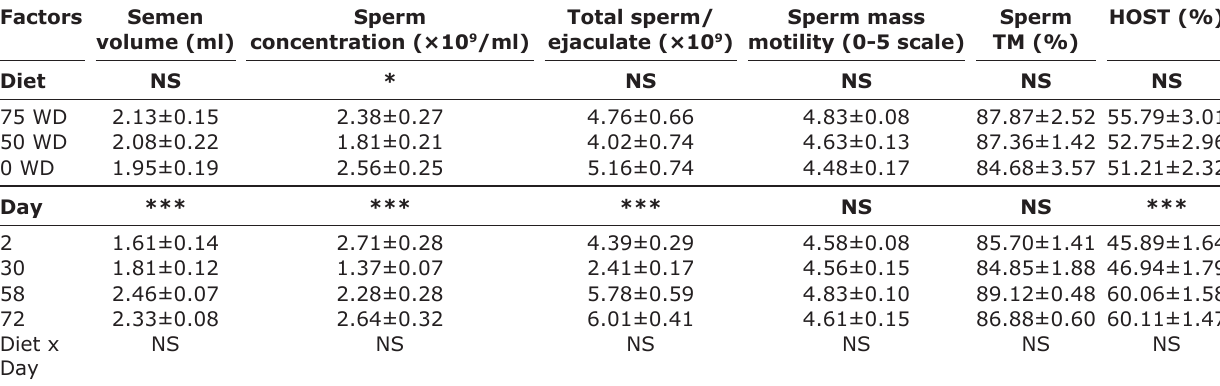
Table-4: Effects of diet and time on seminal parameters of OD rams receiving 75%, 50%, or 0% of wasted date in the concentrate diet.